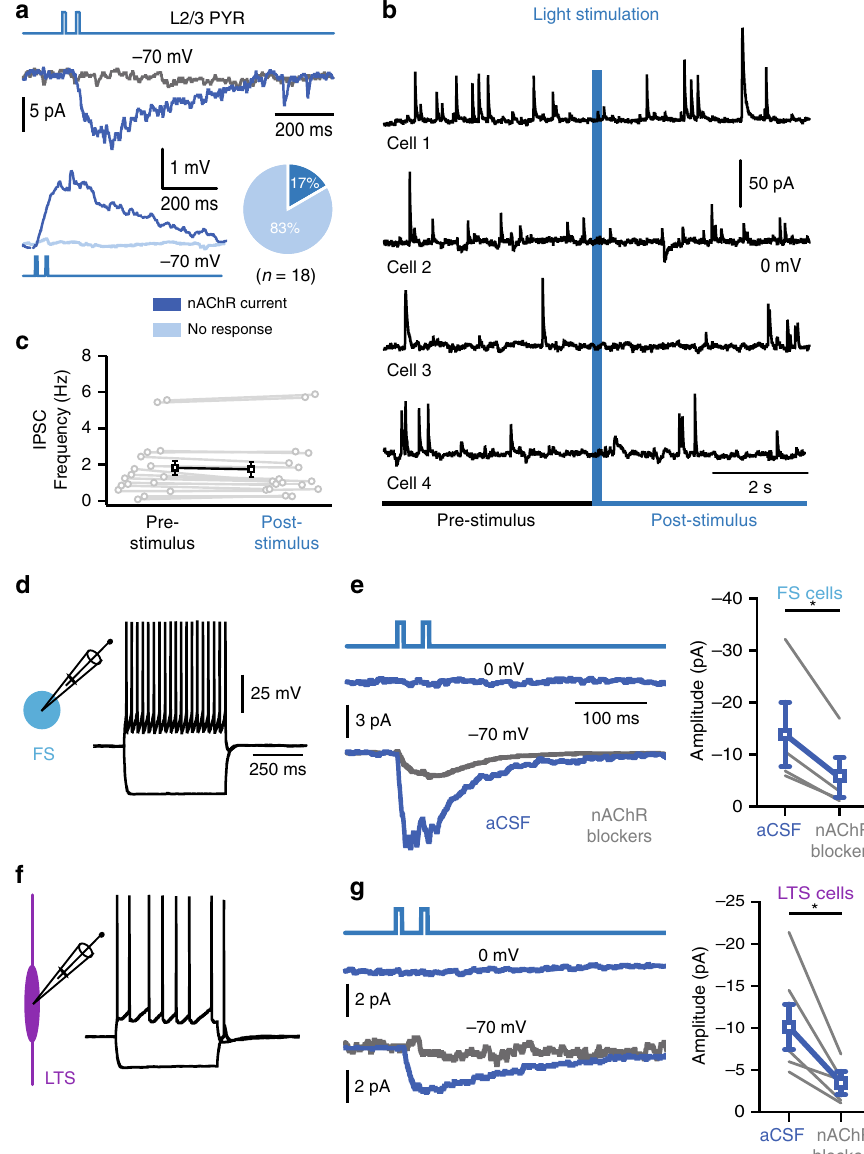
Fig. 3 Direct excitation, but no disinhibition by ChAT-VIP neurons. a Example traces of postsynaptic responses in a rat L2/3 pyramidal neuron upon ChR2- mediated activation of ChAT-VIP interneurons with blue light (470 nm, 10 ms, 25 Hz, top trace). The postsynaptic responses were blocked by nAChR antagonists (MLA 100 nM and MEC 10 µ M, grey trace). The majority of L2/3 pyramidal neurons did not show a response to ChAT-VIP neuron activation (light blue trace). Pie chart showing the percentages of L2/3 pyramidal neurons with nAChR-mediated postsynaptic response (dark blue) and without (light blue). b Example traces of L2/3 pyramidal neurons recorded at 0 mV receiving spontaneous GABAergic IPSCs. Five blue-light pulses were applied (25 Hz, 10 ms). c Comparison of spontaneous IPSC frequency in L2/3 pyramidal neurons before and after ChR2-mediated activation of ChAT-VIP interneurons with fi ve blue-light pulses (25 Hz, 10 ms), (IPSC frequency pre-stimulus: 1.809 ± 0.389 Hz, post stimulus: 1.732 ± 0.411 Hz, p = 0.2310, paired t -test, two-tailed, t = 1.245, df = 16; n = 17; mean ± SEM). d AP pro fi le of a rat mPFC L2/3 FS interneuron in response to somatic step current injection ( + 200 pA and − 150 pA). e Left: Example traces (average of single 10 traces) of postsynaptic responses in an FS interneuron upon ChAT-VIP interneurons with blue light (470 nm, 10 ms, 25 Hz, top trace). Middle trace: example trace recorded at 0 mV showing absence of an IPSC ( n = 0/6). Bottom traces: light-evoked postsynaptic currents ( n = 4/6) in absence (blue trace) or presence of nAChR blockers (MLA 100 nM and MEC 10 µ M, grey trace). Right: Summary plot of the postsynaptic current amplitudes and blocked by nAChR blockers. f AP pro fi le of a L2/3 LTS interneuron. g As in ( e ) but for a rat mPFC L2/3 LTS interneuron. No GABAergic IPSCs at 0 mV were observed following light-evoked activation of ChAT-VIP interneurons ( n = 0/8). A subgroup of LTS neurons showed light-evoked postsynaptic currents ( n = 5/8) at − 70 mV (blue trace) that was blocked by nAChR antagonists (MLA 100 nM and MEC 10 µ M, grey trace). Right: Summary plot of the postsynaptic current amplitudes. Summary plots show averages ± advance spiking in L1 neurons that did not show co-transmission during ramp depolarizations (Fig. 5h, i), suggesting that the of GABA (Supplementary Fig. 5F). In line with these fi ndings, at postsynaptic GABAR currents provided shunting inhibition that near-AP threshold membrane potentials in L1 interneurons, blue- postponed AP fi ring. Gabazine did not alter the input resistance light activation of ChR2-expressing ChAT-VIP interneurons (Fig. 5i inset), nor excitability of L1 interneurons and did not